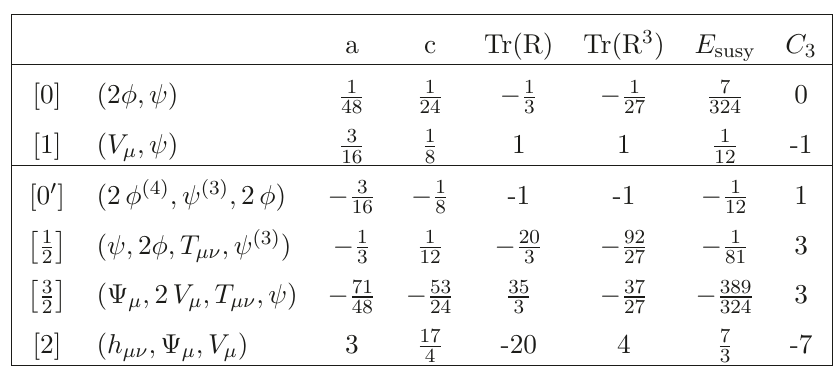
Table 2 . The values of the conformal anomaly coefficients and their combinations Tr(R) = 16 (a c), Tr(R 3 ) = 16